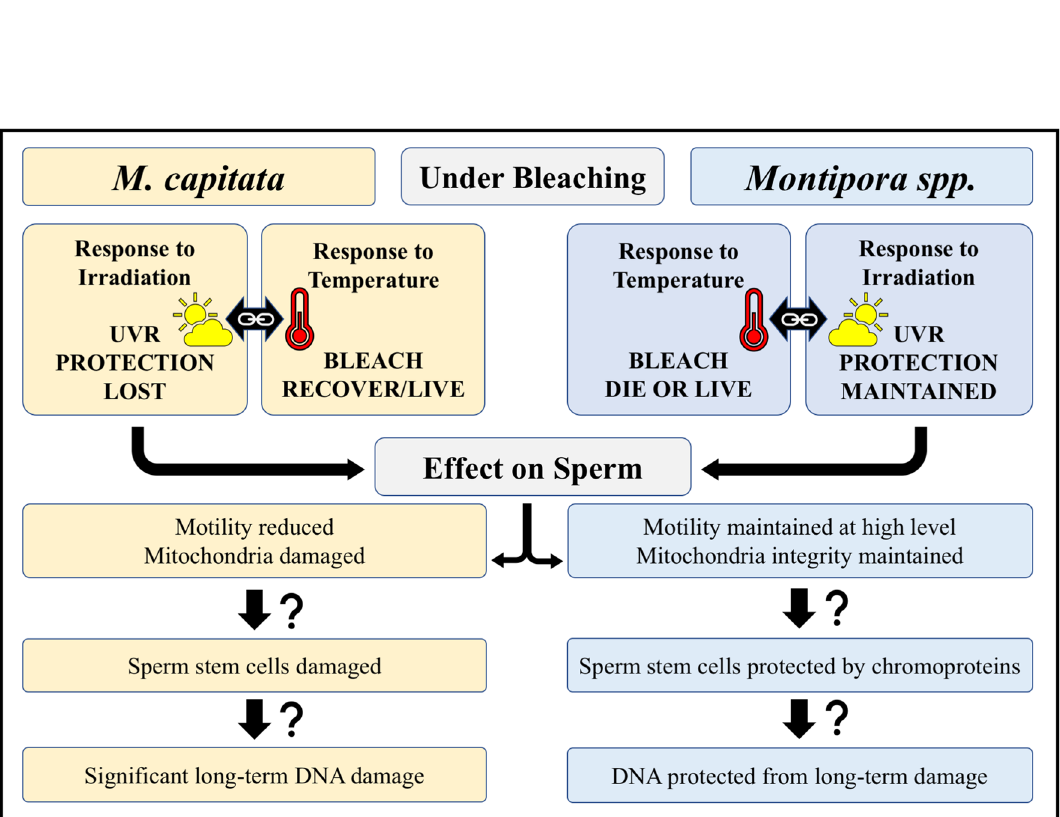
Figure 10. Hypothesized mechanisms of protection ( Montipora spp .) or damage ( M. capitata ) of sperm from UVR while bleached. While Montipora spp. is more likely to experience mortality, if a portion of the colony lives, its reproduction might be protected. Conversely, if the M. capitata colony is more likely to recover, its reproduction might sustain longer-term damage due to loss of UVR protection while